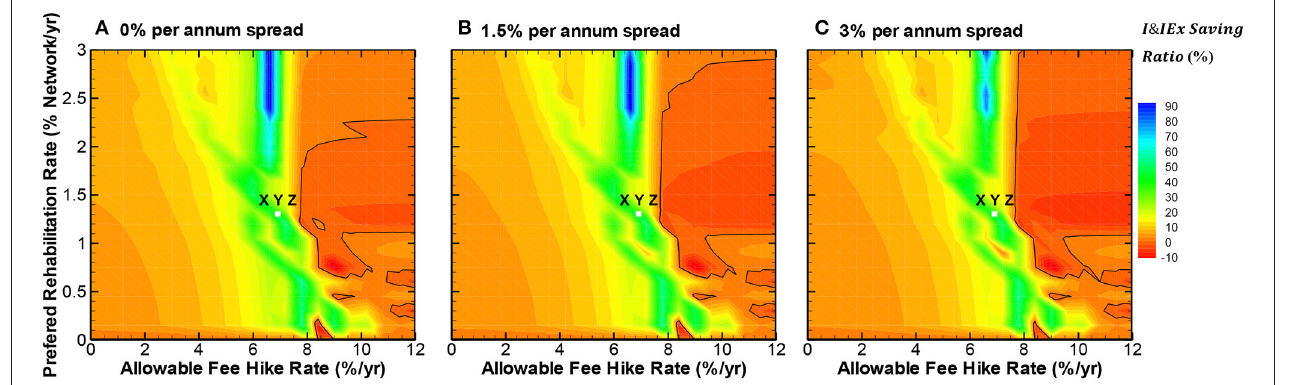
FIGURE 7 | (A–C) Impact of allowable fee hike and preferred rehabilitation rates on I & IEx saving